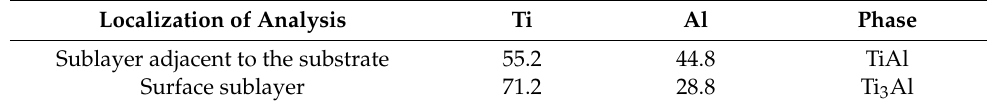
Figure 9. Microstructure of the surface layer with marked points of the performed analyses.